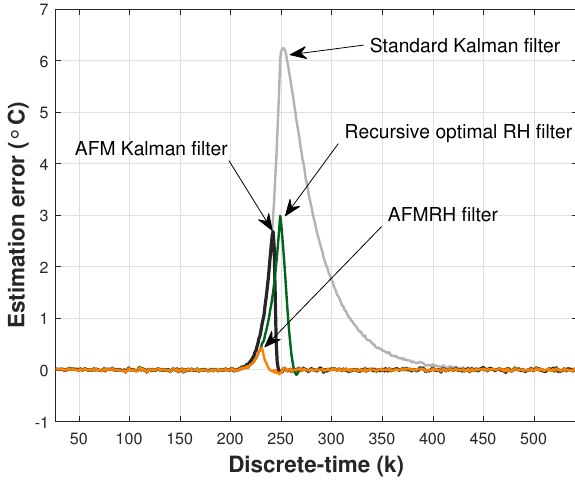
Figure 2. Estimation errors of